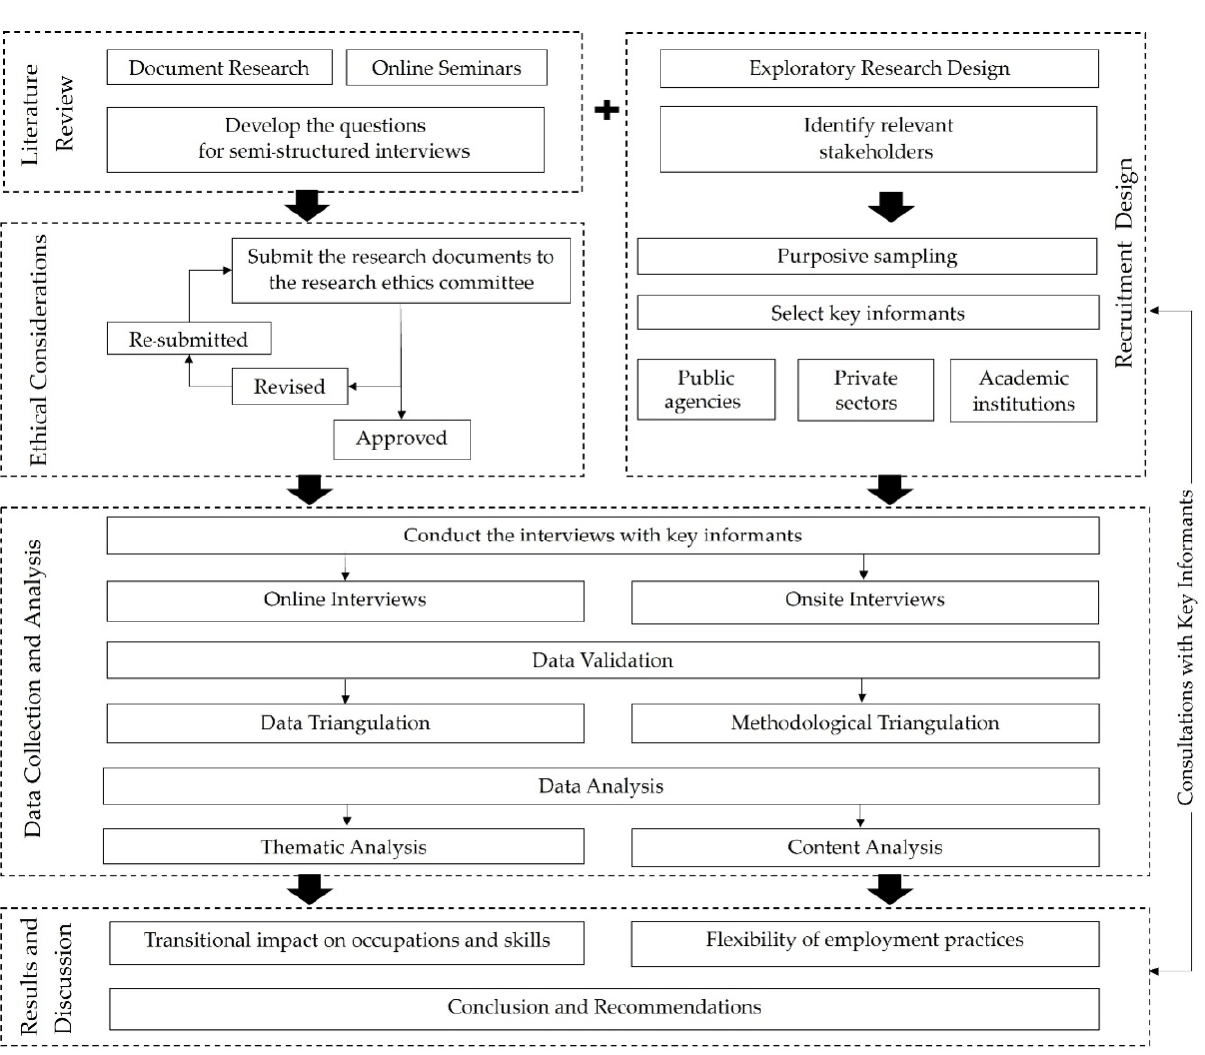
Figure 2. Flowchart of the conducted research. Source: summarized by authors.